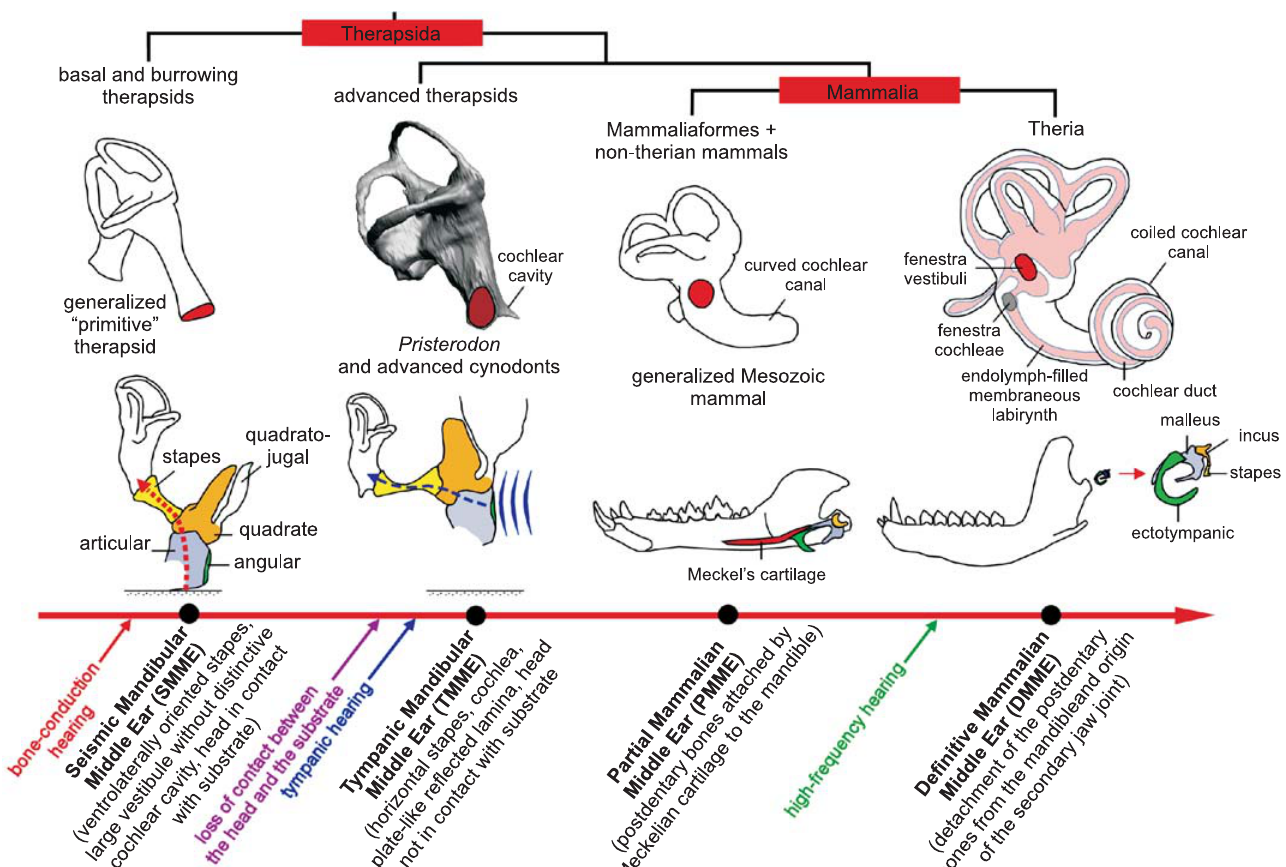
Fig. 9. Co-evolution of the cochlea and middle ear in synapsids. Hearing in primitive or burrowing non-mammalian synapsids was predominantly by bone conduction from the ground vibration via the mandible. The tympanic hearing started to assume a more important role as the head became lifted from ground due to a more upright forelimb posture. Adaptations to tympanic hearing and modifications of the middle ear for better sensitivity to airborne sound include: an enhanced acoustical isolation of the postdentary bones from the dentary, an enlarged reflected lamina, a smaller stapes footplates and a more horizontal oriented stapes, an elongate medial trochlear condyle of the quadrate. All these coincided with the origin of a distinctive cochlear cavity. Concurrent with middle ear modifications, the inner ear developed a more laterally facing fenestra vestibule and a ventral cochlear cavity. Later, the de- tachment of the postdentary bones from the mandible and the elongation of the cochlear canal were further steps towards a refined sensitivity to airborne sound, especially in higher frequencies. Partially redrawn from Luo et al. (2011), Cox (1962), and Luo